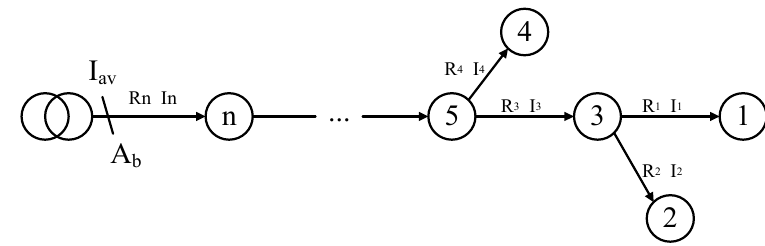
Figure 1. Equivalent resistance method calculation structure diagram.